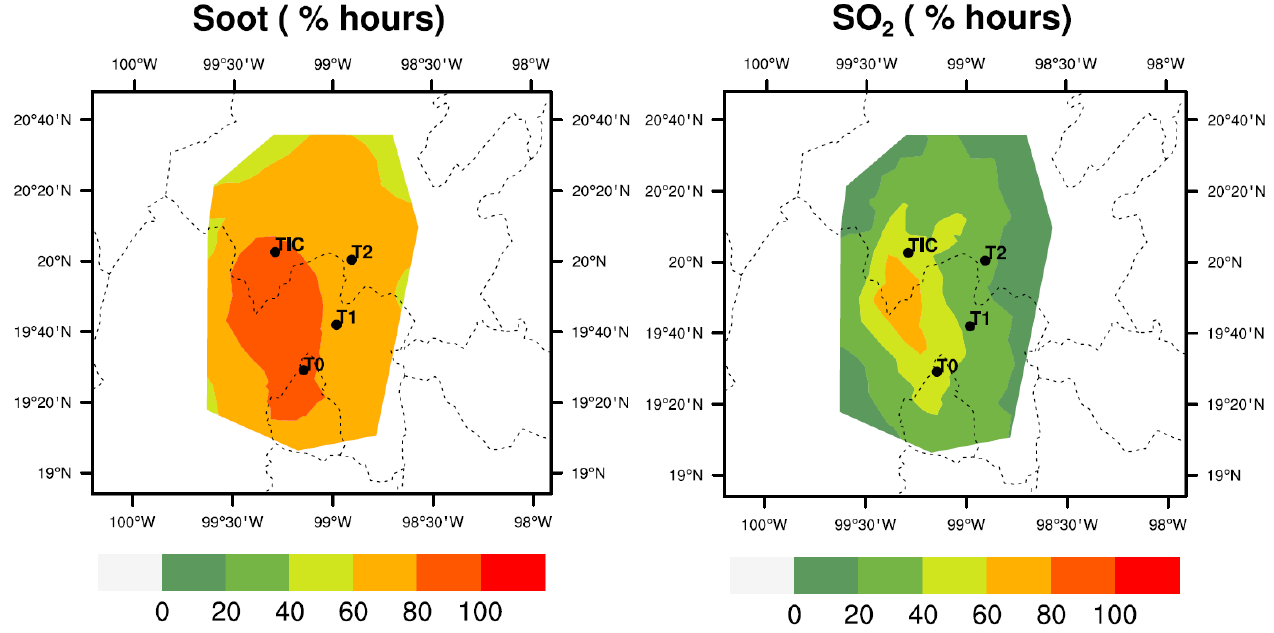
Fig. 7. Suggested spatial contribution of SO 2 and EC in the period from 22 to 27 March of